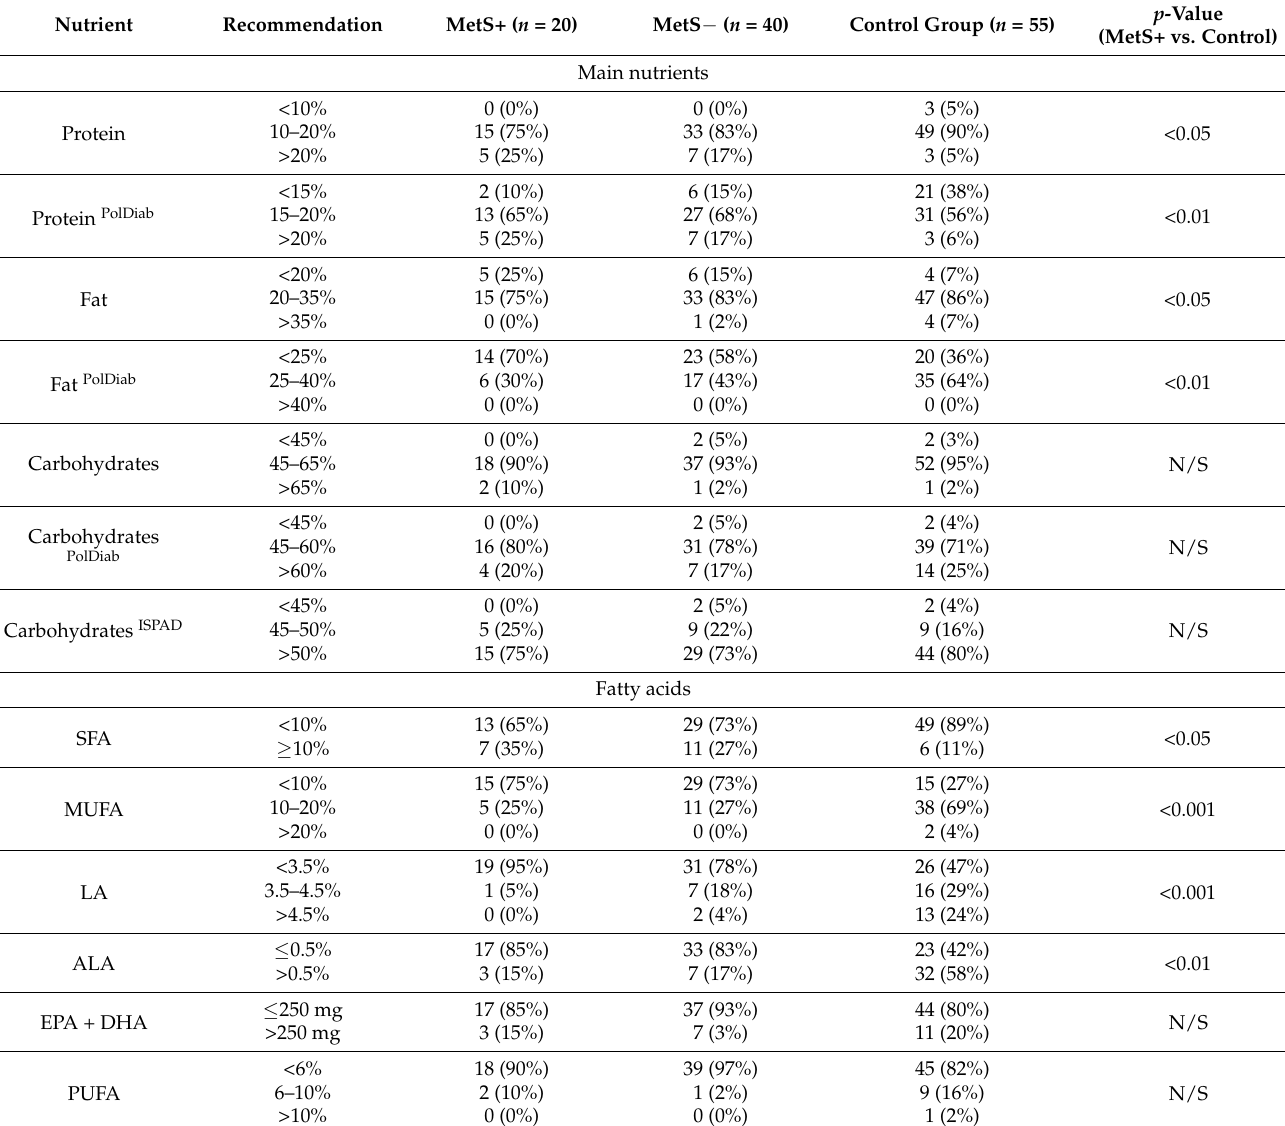
Table 8. Implementation of nutritional standards for selected